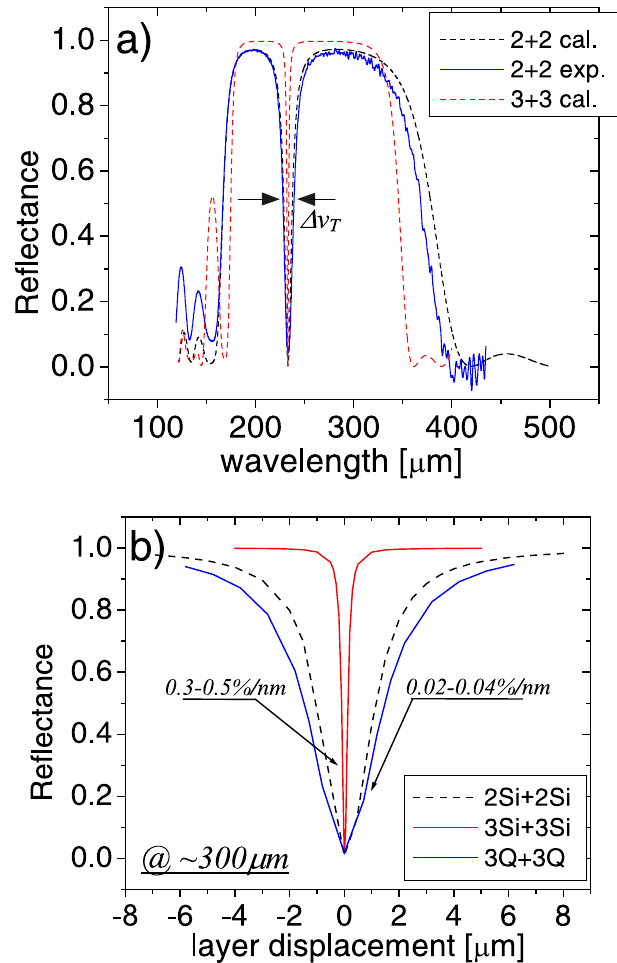
FIG. 12. (Color) Narrow transmission peaks generated by em- ploying PhC structures of the type 2 þ 2 and 3 þ 3 where a defect layer is enclosed between two high reflectivity stacks. In (a), the measured fractional bandwidth (FWHM) amounts to 3 : 5 (cid:7) 10 (cid:2) 2 (FTIR spectral resolution: 0 : 1 cm (cid:2) 1 ) confirming fairly well the predicted value for the 2 þ 2 stack. The band- width is reduced further down to 9 (cid:7) 10 (cid:2) 3 using the 3 þ 3 configuration. In (b), 3Q þ 3Q shows the corresponding change in transmission that is induced by varying the center vacuum defect layer and keeping the wavelength fixed. In contrast, Si PhC provides an order of magnitude larger transmission gra- dients with the same number of cells assembled in the stack (cid:1) 4 (cid:7) 10 (cid:2) 4 =(cid:7) 3Si þ 3Si ( (cid:2) (cid:7) T C